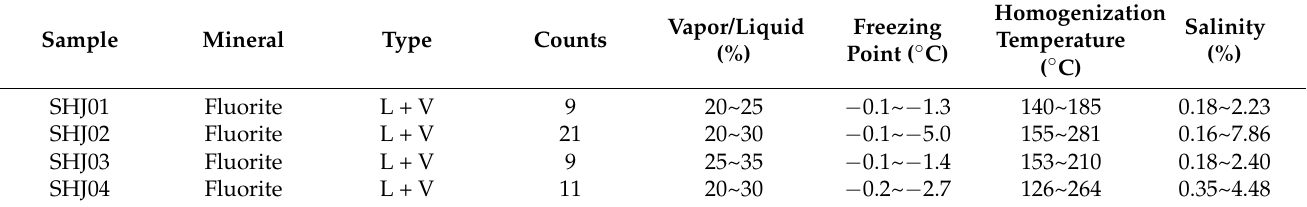
Table 4. Results of fluid inclusion analysis of fluorite of the Shuanghuajiang fluorite deposit.